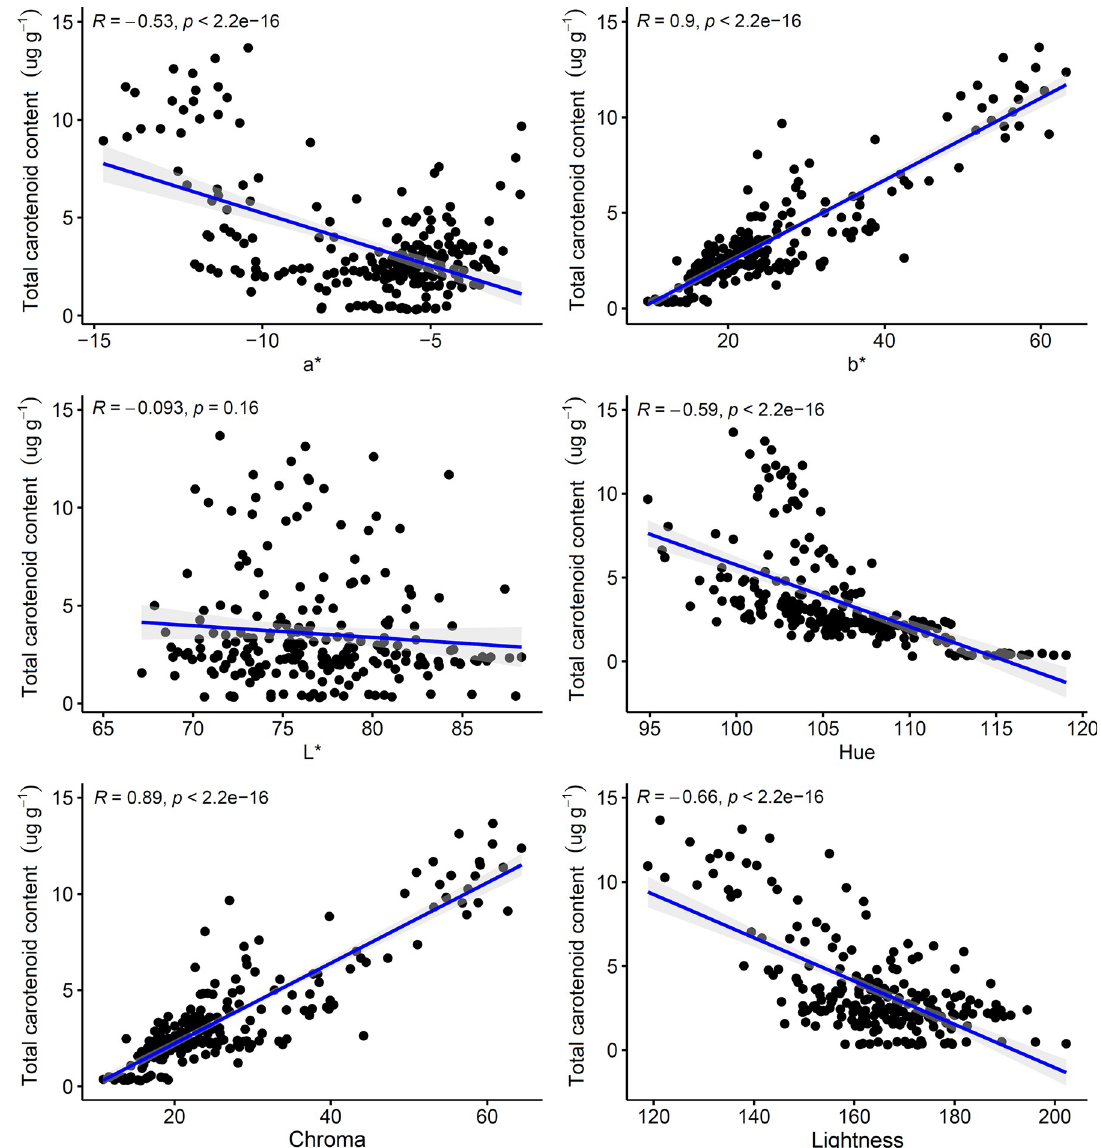
Fig 1. Scatter plots of the total carotenoid content and colorimetric indices. Numerical values represent Pearson’s correlation coefficients between colorimetric indices and total carotenoid content. The blue line represents the 1:1 isoline. Based on PCA, the cassava genotypes were categorized into five groups. Groups 1, 2, 3, 4 and 5 comprised 76, 34, 26, 21 and 71 genotypes, respectively. Groups 1 and 2 consisted of genotypes with low TCC values (1.91 μ g g -1 and 1.82 μ g g -1 , respectively) and low b � and chroma, in addition to the highest L � , lightness and hue (Fig 4). Groups 3 and 5 consisted of cassava genotypes with yellow pulp, but with moderate TCC contents (4.82 μ g.g -1 and 3.60 μ g. g -1 , respectively) and moderate lightness values (varying from 158 to 159). However, these two groups differed in their values of a � (-10.23 and -4.60 in groups 3 and 5, respectively), b � (36.48 and 22.20), L � (78.60 and 73.10), hue (105.59 and 101.87), and chroma (37.93 and 22.72).